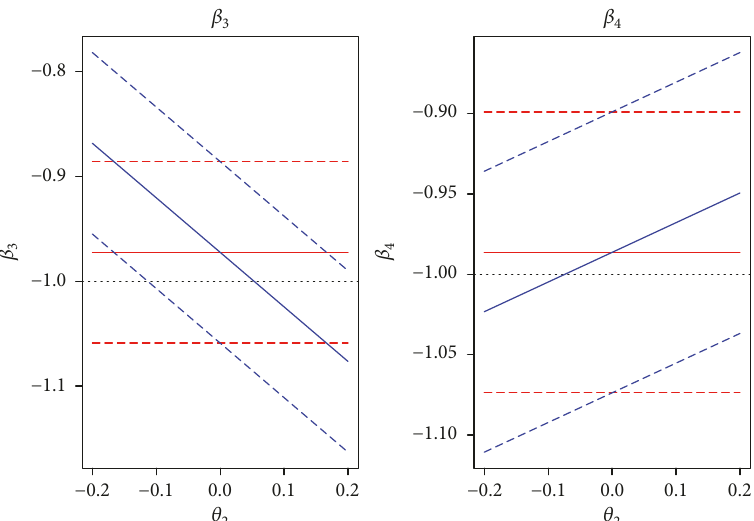
Figure 5: CI under MNAR: 𝛽 = (−2,−2, −1, −1) , 𝜃 = (−0.5,−0.5) , 𝜃 𝑇 2 =0.1. The blue lines are the adjusted estimates, and red lines are the unadjusted estimates. The horizontal lines are at the true values.